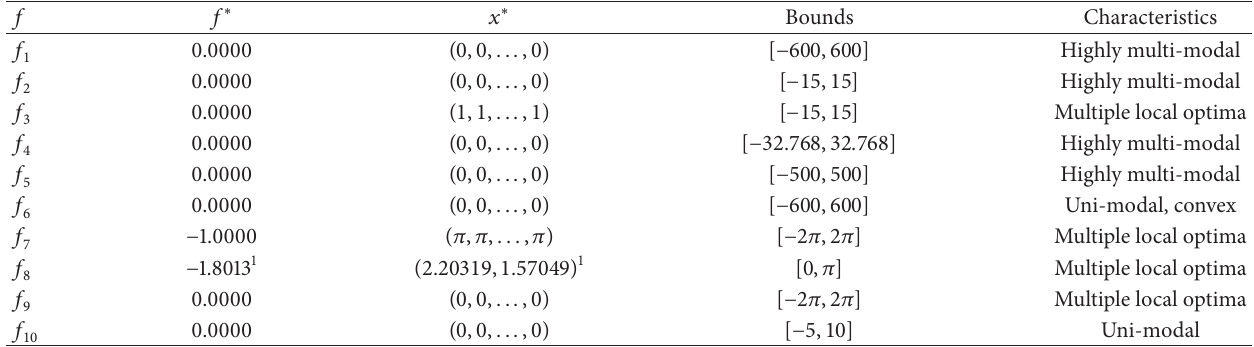
Table 2: Properties of benchmark